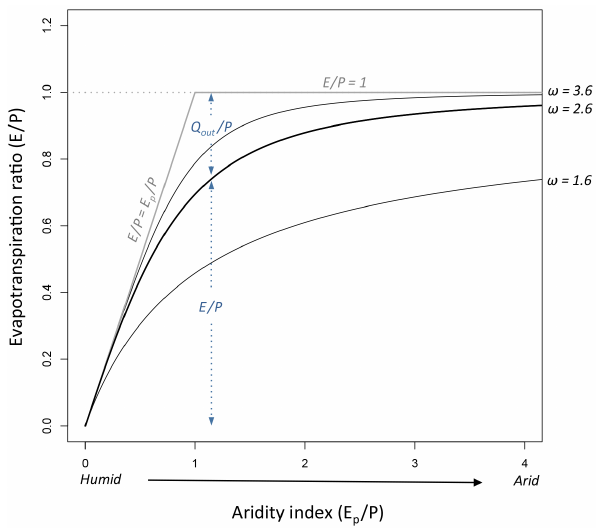
Figure 4. Illustration of the Budkyo framework showing curves with three different shape parameters (black lines, ω = 1.6, 2.6 and 3.6) in relation to the water ( E/P = 1) and energy ( E/P = E p /P ) limits of the system, grey